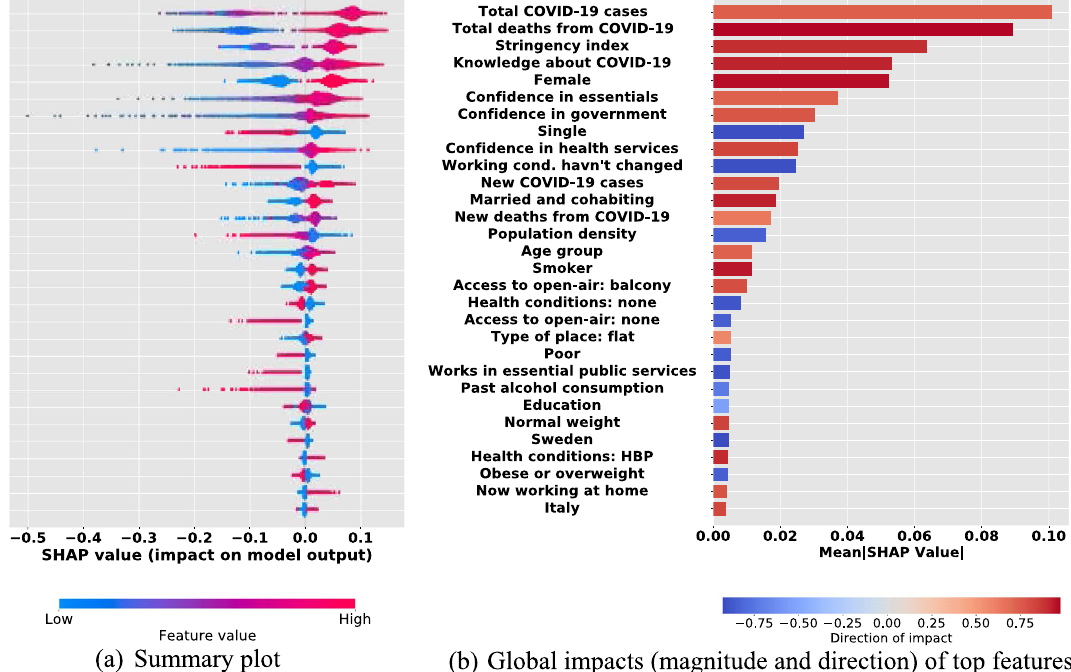
Figure 1. Top 30 predictors of self-protecting behaviors. Notes : Panel ( a ) is the SHAP summary plot for the Random Forests trained on the pooled data set of five European countries to predict self-protecting behaviors responses against COVID-19. The plot displays the top 30 features on prediction (the top on the y-axis is the most important) and the distribution of the impacts of each predictor on the model prediction, which includes a set of distributions where each dot corresponds to an individual. When multiple dots arrive at the same coordinate in the plot, they pile up to show density. The colors correspond to the feature values: red for larger values and blue for smaller ones. A negative SHAP value (extending to the left) shows reduced self-protecting behavior, while a positive (extending to the right) shows an increased self-protecting behavior. Panel ( b ) displays threefold information: (i) the direction of association captured by the correlation between the feature and SHAP values (red for positive and blue for negative); (ii) strength of the direction of association shown by the darkness of each color gradient; (iii) the magnitude of feature’s marginal impact measured as the average of absolute SHAP